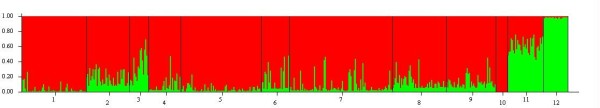
Admixture analysis using STRUCTURE, in which individuals were assigned on the basis of the most likely K (in this case, K = 2). Populations are numbered from 1 to 11 following the order in Figure 1. Population 12 is a pure brown trout population (Chisone). Each vertical bar represents one individual, partitioned into two segments according to the proportion of marble trout (red) and brown trout (green).